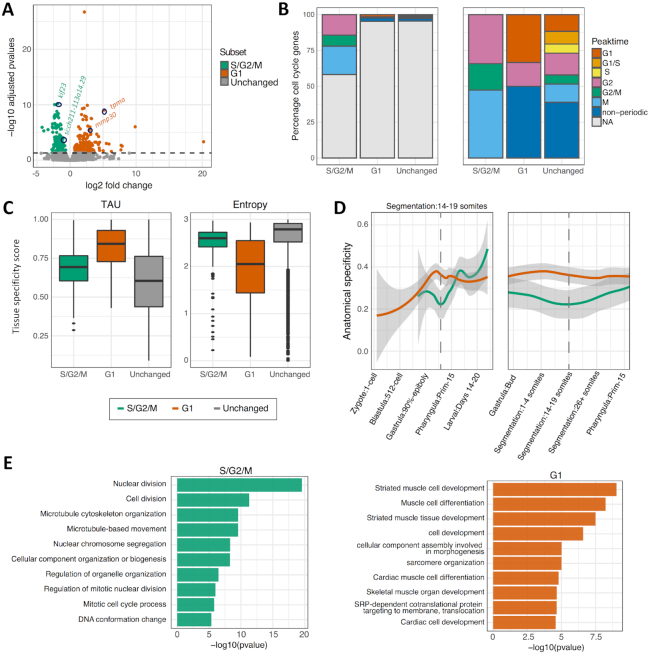
Classification of genes differentially expressed between G1 and S/G2/M segregated cells. (A) Volcano plot of all consensus clusters (CCs) in known promoter regions, coloured by significance. Location of genes shown in Figure 2B as well as the identity of top significant differentially expressed genes between populations highlighted by circles and gene names. (B) Bar plot of the percentage of promoters overlapping a human annotated cell cycle periodic gene from Cyclebase for each differentially expressed group and the CCs unchanged between the two groups. Left panel, full sample groups (n = 138, 190 and 8406, S/G2/M, G1 and unchanged respectively). Right panel, cell cycle periodic genes (n = 43, 6 and 246, S/G2/M, G1 and unchanged respectively). (C) Box plot of tissue specificity scores, based on adult zebrafish tissue for genes upregulated in G1 and S/G2/M and unchanged. (D) Anatomical specificity scores, based on expression in embryonic zebrafish tissues, for genes upregulated in G1 and S/G2/M. Left panel, anatomical specificity scores across development with key stages marked on x-axis. Right panel, anatomical specificity scores around stage at which the samples were collected (14-somite). Grey shading marks standard error, dashed line marks 14–19 somite stage. (E) Gene ontology of biological processes with their corresponding P-values.